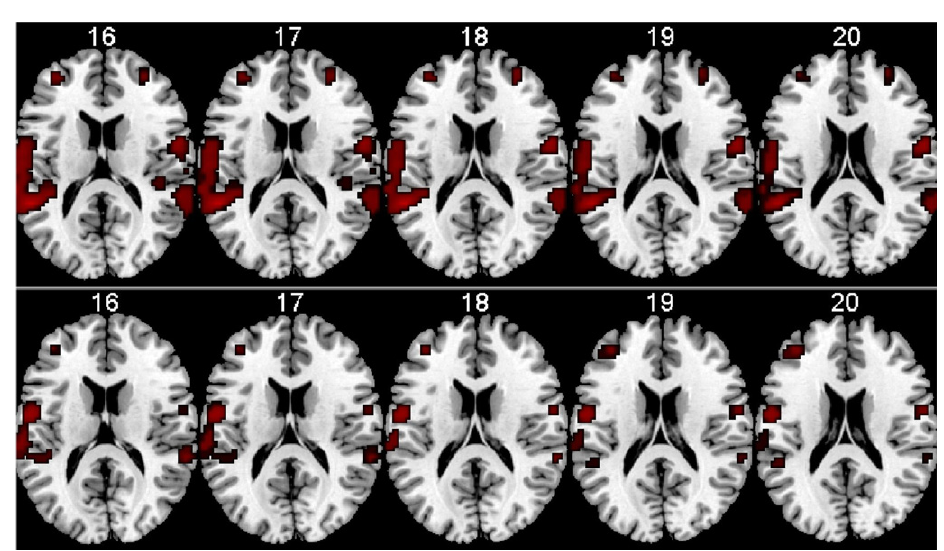
Figure 8. fMRI BOLD activation in the left and right peri-Sylvian areas when listening to dichotic presentations of CV-syllables. The upper row shows activations for the Drug-naive condition, the lower row shows the corresponding activations for the Memantine condition. From left to right: Axial slices corresponding to 16–20 mm above the AC-PC midline in the standardized Talairach and Tournoux (1988) coordinate system. Neurological left-right display